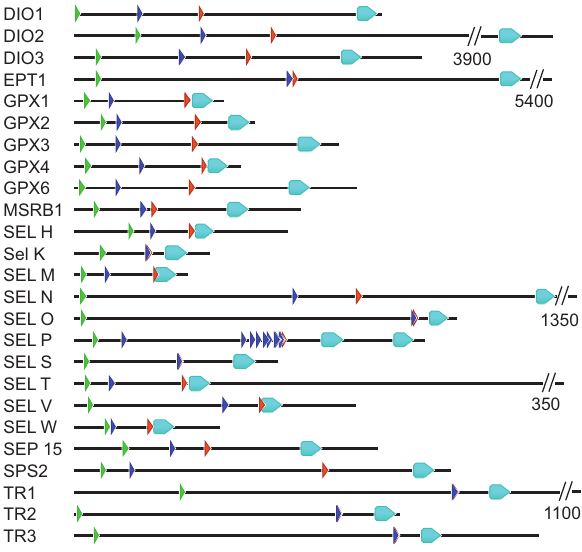
Figure 2 Relative distributions of start codons (green), Sec codons (blue), stop codons (red) and SECIS elements (light blue) within all 25 human selenoproteins. All mRNAs are drawn to scale except for those with the indicated number of bases inserted between the slash